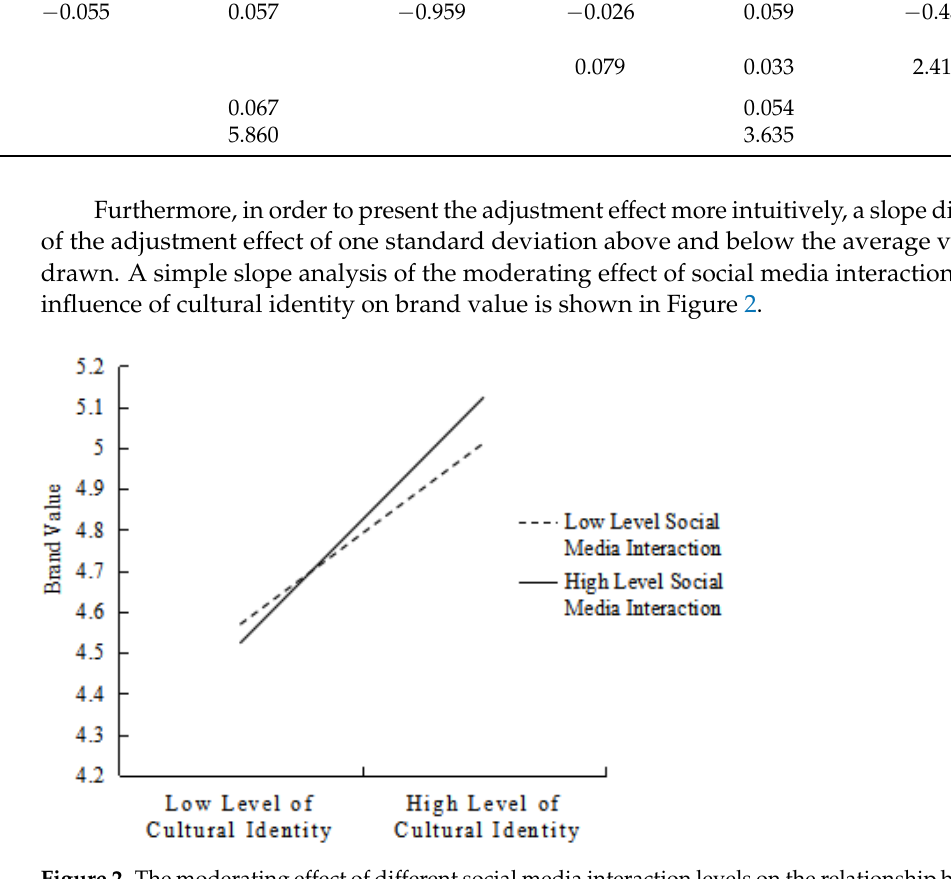
Figure 2. The moderating effect of different social media interaction levels on the relationship between cultural identity and brand value.